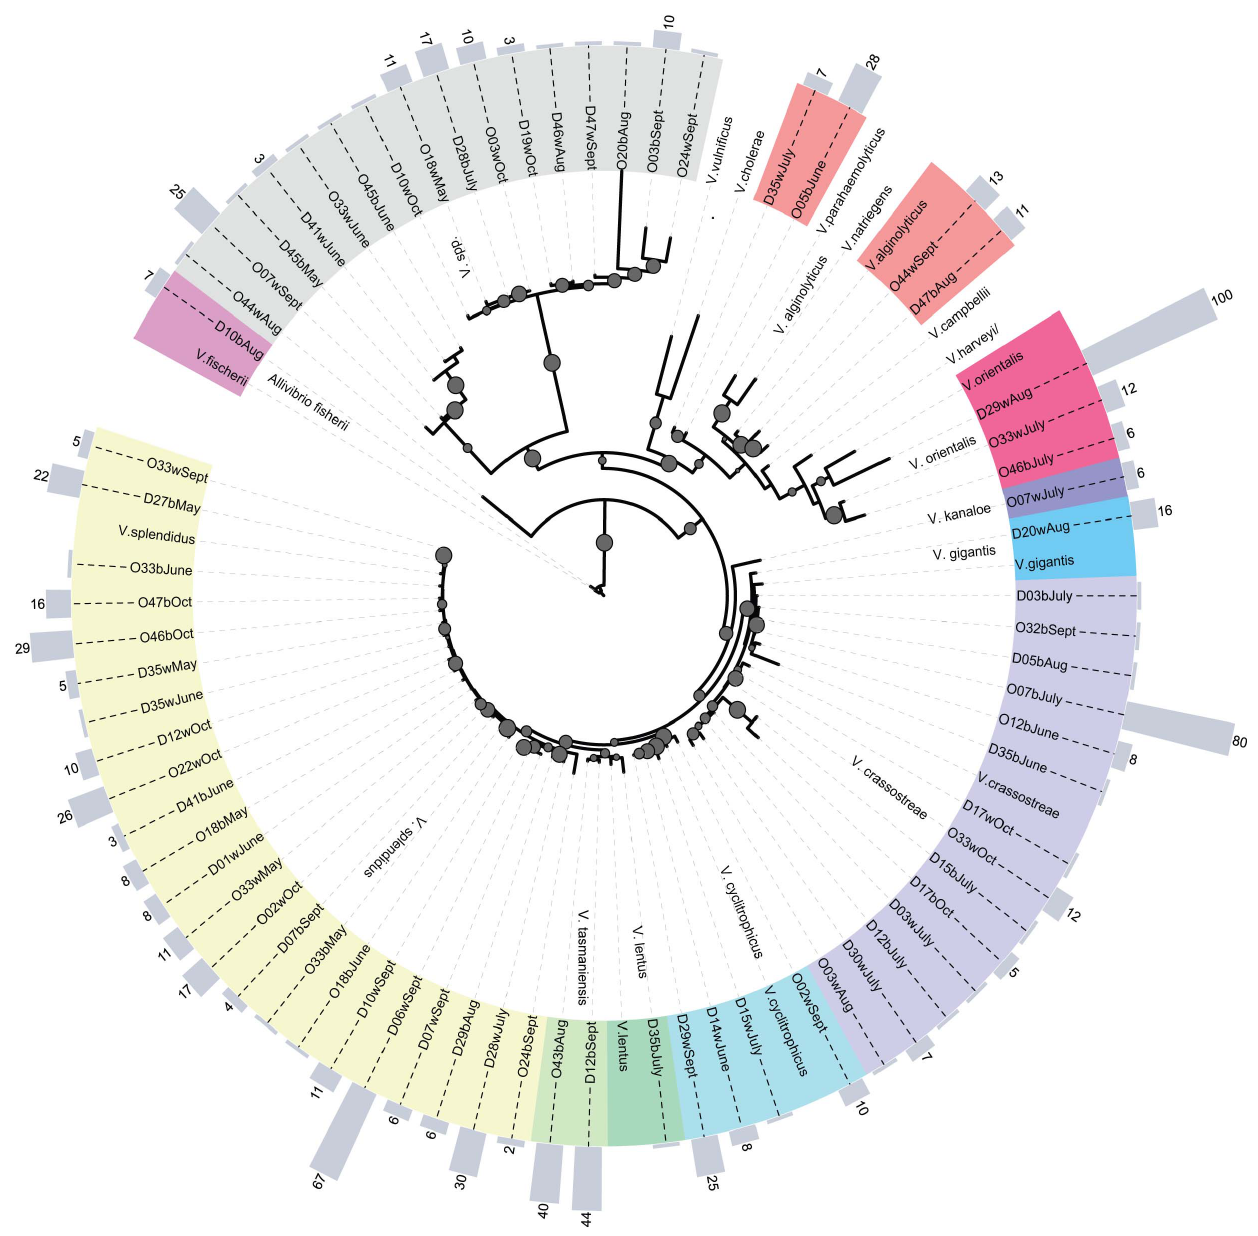
Figure 2. Phylogenetic relationships of Vibrio isolates sampled from oyster hemolymph. Maximum likelihood method (GTR + G + I substitution model) using concatenated sequences of three genes (16S rRNA, GyrB , PyrH ) (2560 bp). Bootstrap percentages above 80% are represented by grey dots at the parent nodes. Virulence of each strain is depicted by the grey bars on the outer ring (a value of 100 corresponds to 100% mortality during inoculation experiments). Assignment to the different clades (see legend) based on 99% sequence similarity by BLASTN analysis is depicted in color on the inner ring.